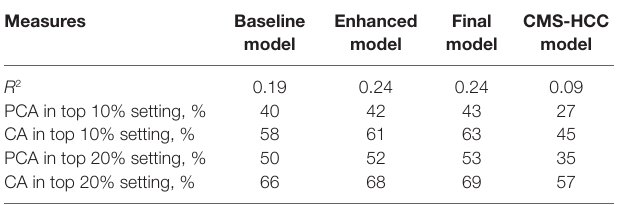
TaBle 2 | Performance measures in baseline model, enhanced model, and final